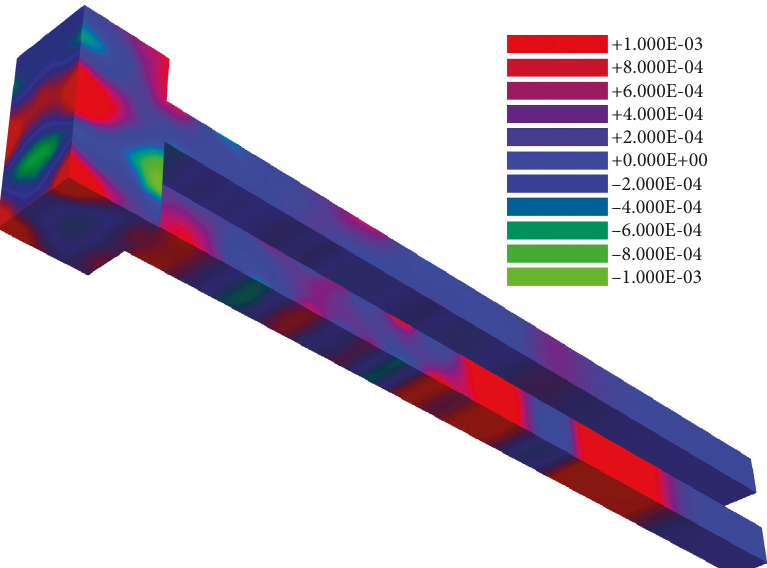
Figure 16: 3D contours of the impact on the top surface (time t